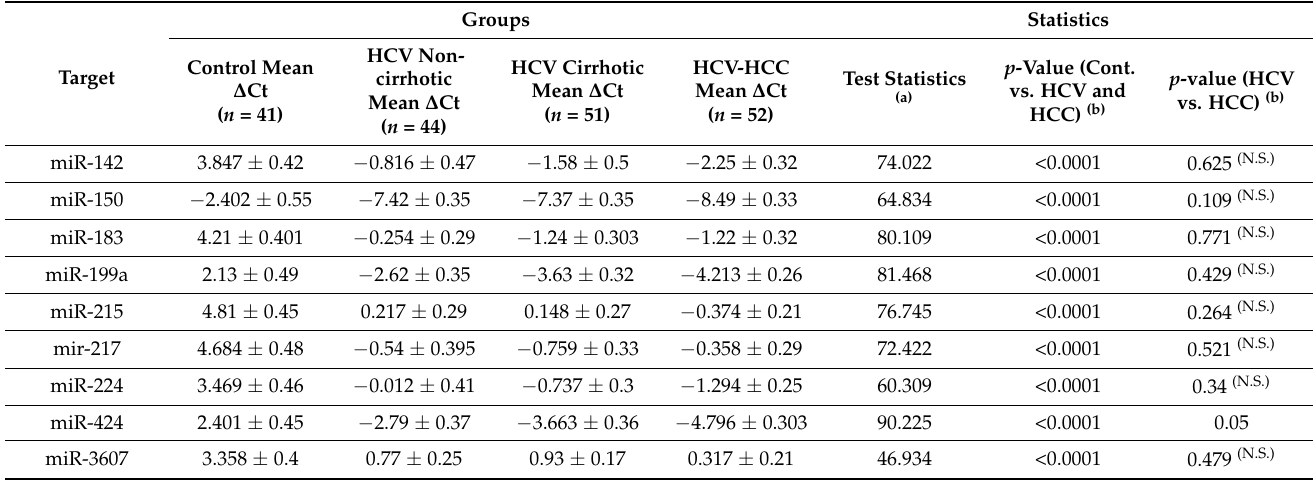
Table 4. Mean of ∆ Ct of target miRNAs among the studied groups.